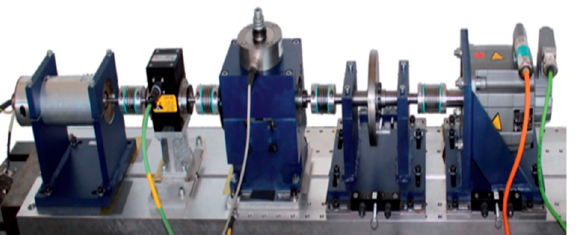
Figure 6. PU data testbed: test motor, measuring shaft, bearing module, flywheel, load motor (from left to right) [1]. Table 2. CWRU dataset used in the paper and domain description. Table 2. PU dataset used in the paper and domain